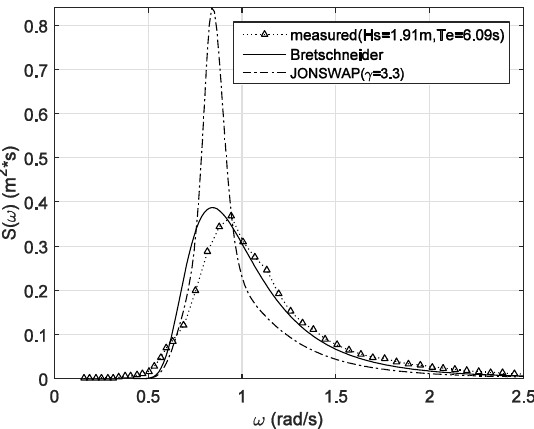
Figure 16. Measured spectrum (average) and the corresponding Bretschneider and JONSWAP spectra ( T e = 6.09 s, H s = 1.91 m), T pc is calculated using Equation (27).